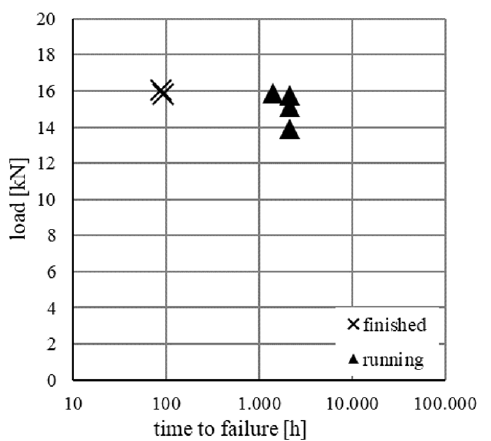
Figure 8. Load - time to failure diagram of creep tests at an insulation thickness of 350